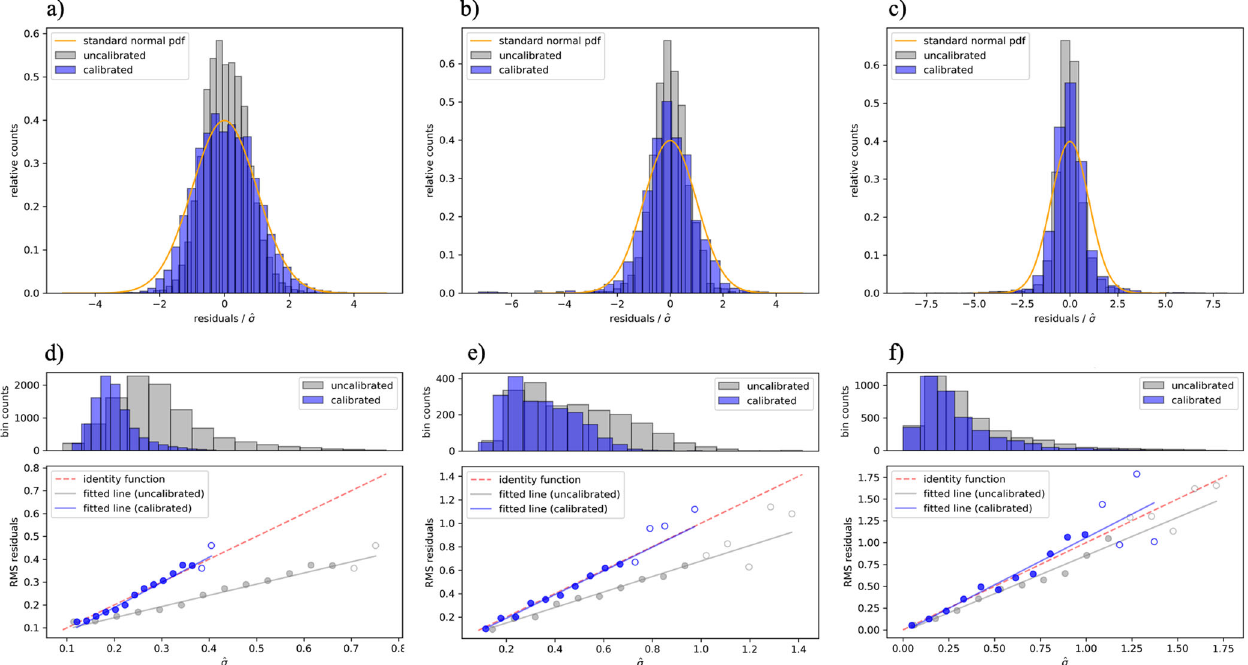
Fig. 1 Calibrated and uncalibrated r-statistic and RvE plots for random forest. Distributions of r-statistic values (top row) and RMS residual vs. ^ σ plots (bottom row) for random forest, using the synthetic (panels a and d ), diffusion (panels b and e ), and perovskite (panels c and f ) datasets, shown with both uncalibrated and calibrated ^ σ values. Markers which are not fi lled in represent bins with fewer than 30 points. Statistics for each plot are summarized in Table